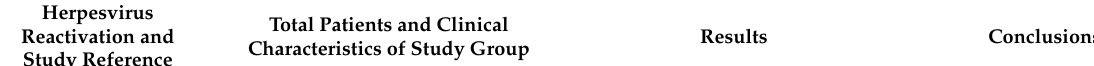
Table 2. Selected studies of herpesviruses reactivations in severely ill COVID-19